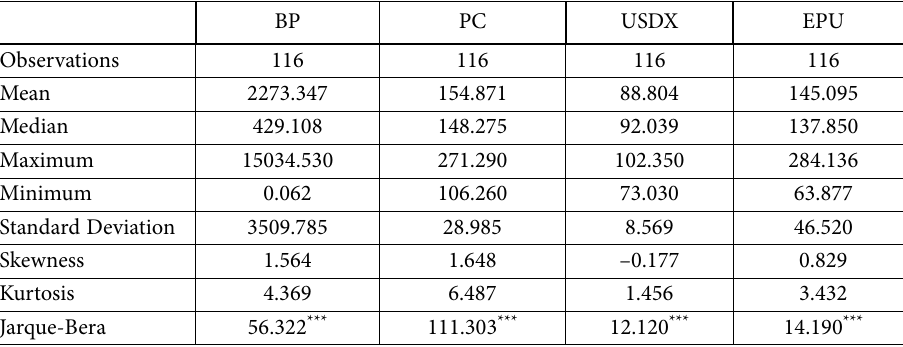
Table 1. Descriptive statistics for BP, PC, USDX and EPU BP PC USDX